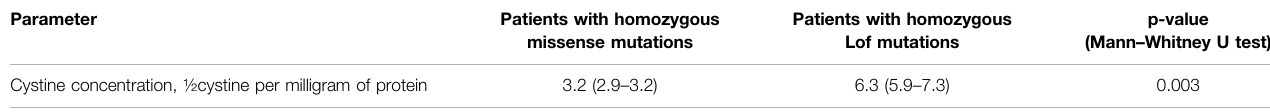
TABLE 2 | Cystine levels in groups of patients with different CTNS mutation types. Parameter Patients with homozygous